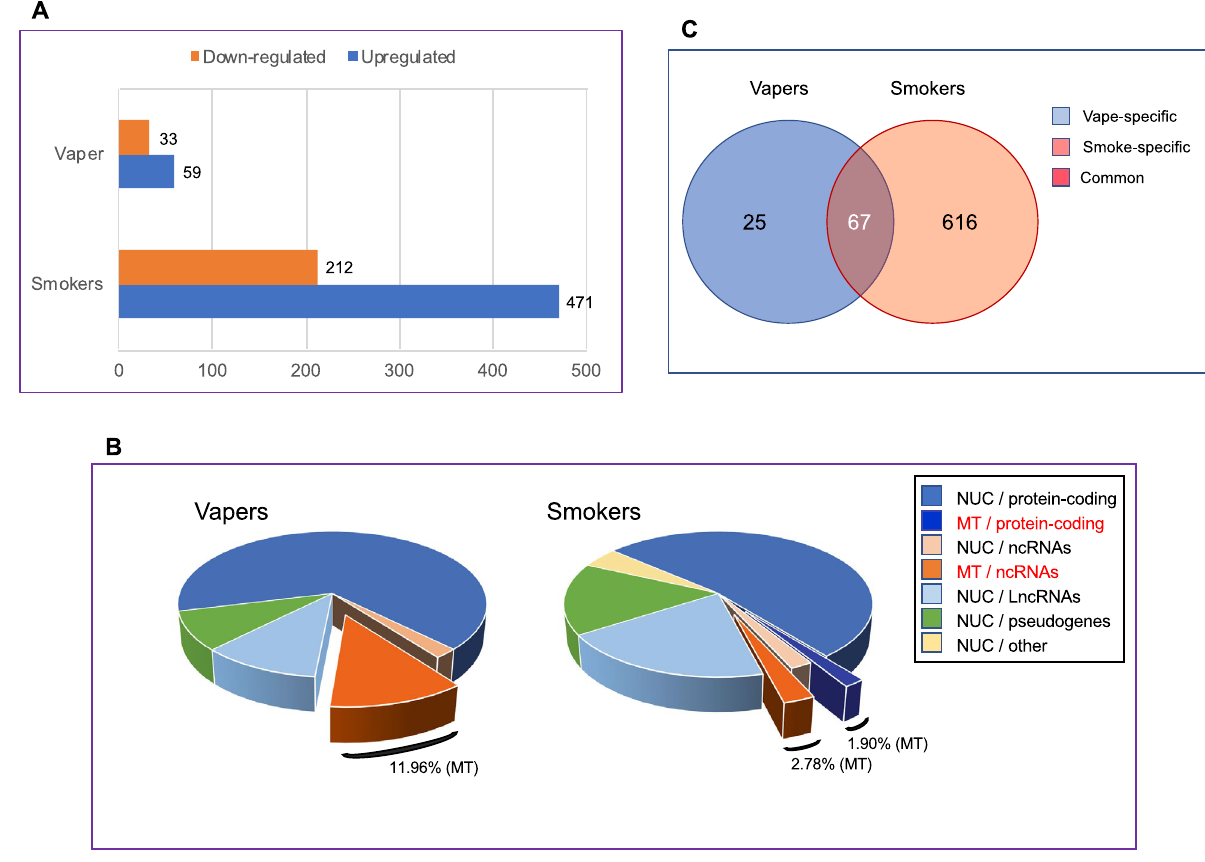
Figure 1. Differential expression of genes detected by RNA-seq in vapers and smokers as compared to controls. (A) Numbers of up-regulated and down-regulated genes in vapers and smokers are indicated (FC > 1.5 and FDR < 0.1) (B) Gene/transcript biotypes (based on Ensembl classification) in vapers and smokers. Percentages of mitochondrial DEGs (protein-coding and noncoding) in vapers and smokers are specified. NUC, nuclear; MT, mitochondrial. (C) Venn diagram of differentially expressed genes (DEGs) in vapers and